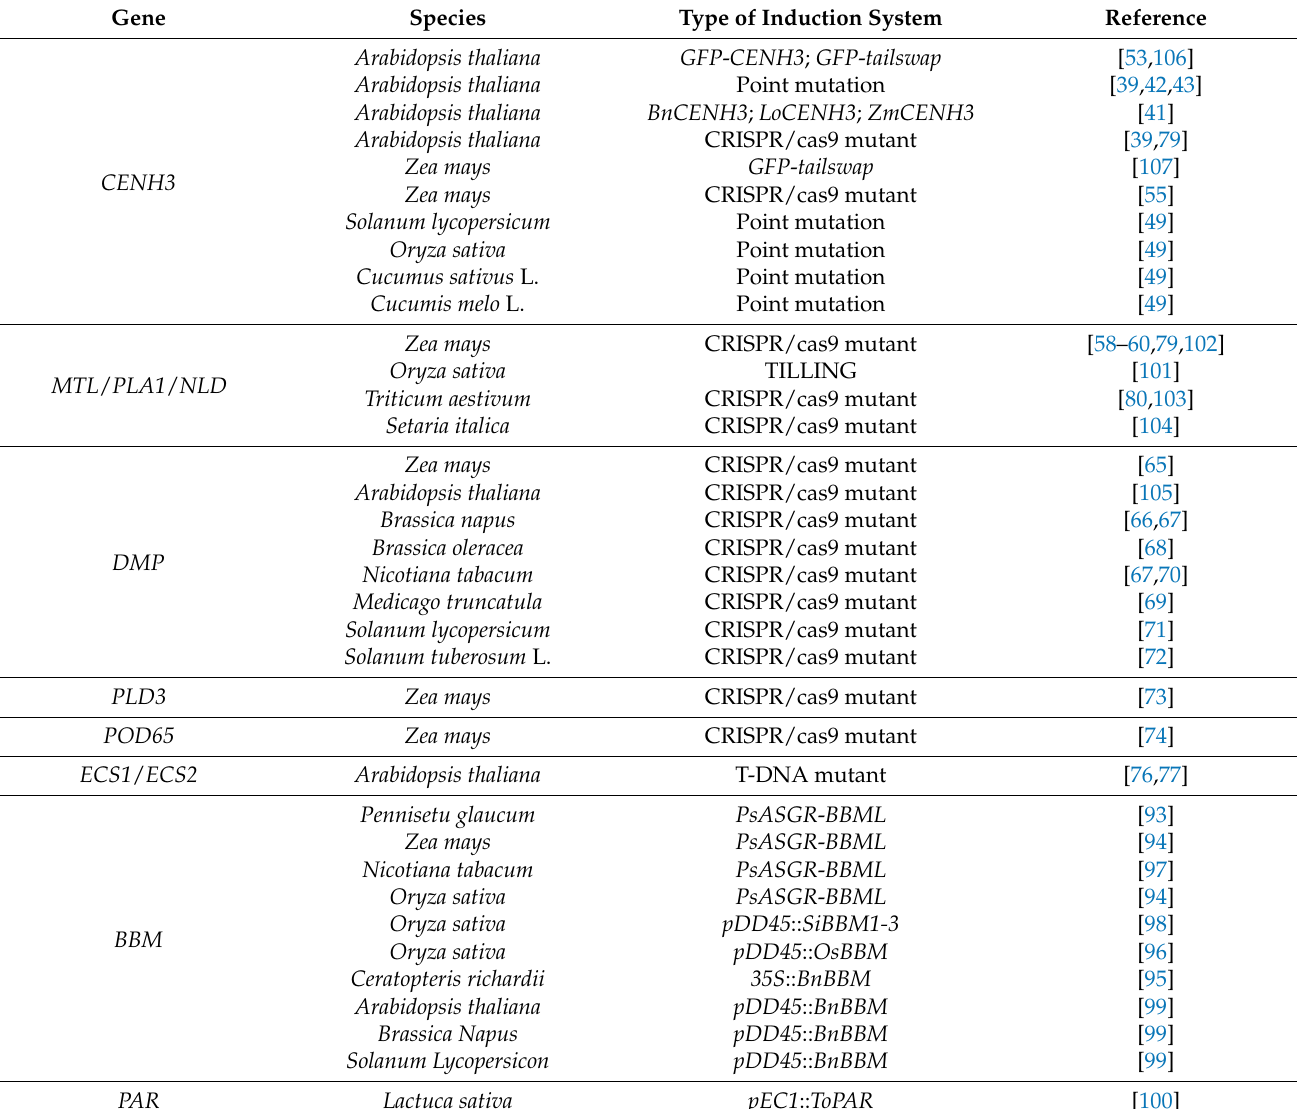
Table 1. List of in vivo haploid systems tested in various